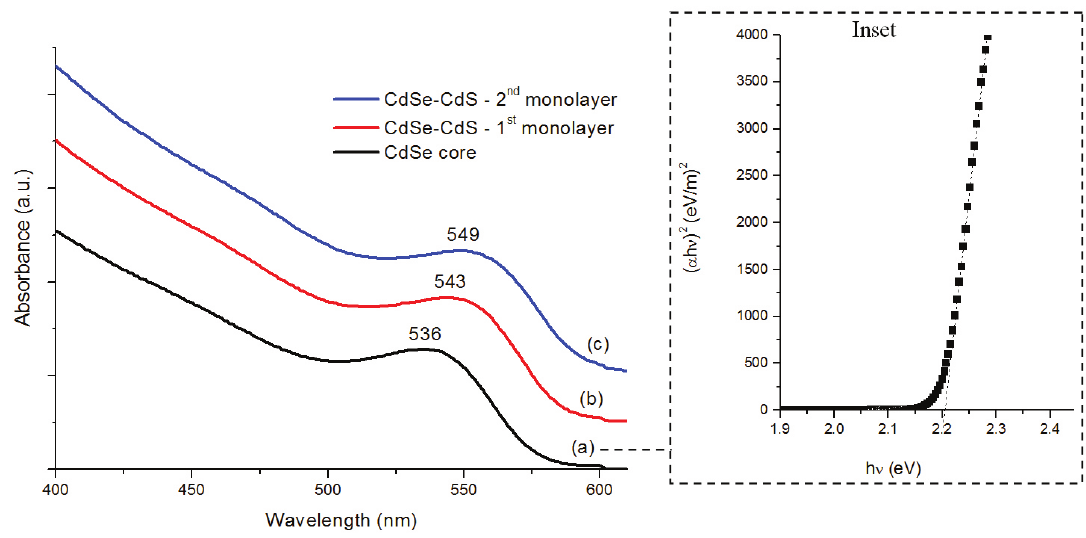
Figure 2. UV–vis spectra of the CdSe core (a), CdSe/CdS – 1 st monolayer (b) and CdSe/CdS – 2 nd monolayer (c) after three days of preparation. Inset: Optical absorption spectrum of the CdSe core